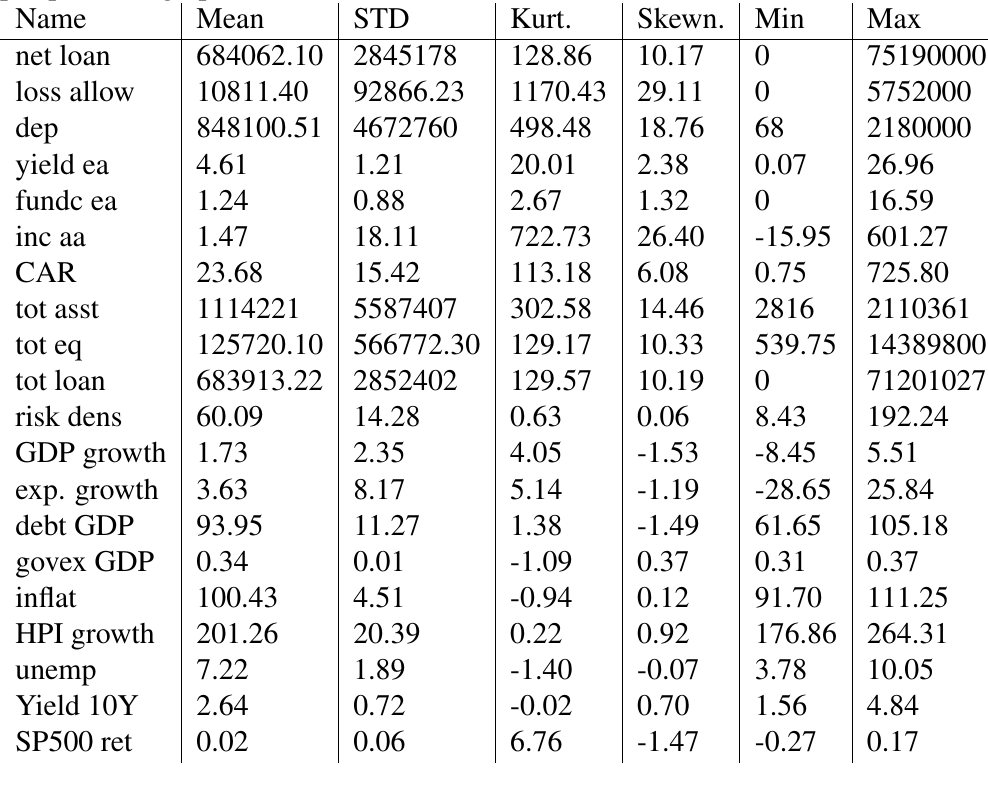
Table 2: Variables used in the experimental phase: overall main statistics before pre-processing